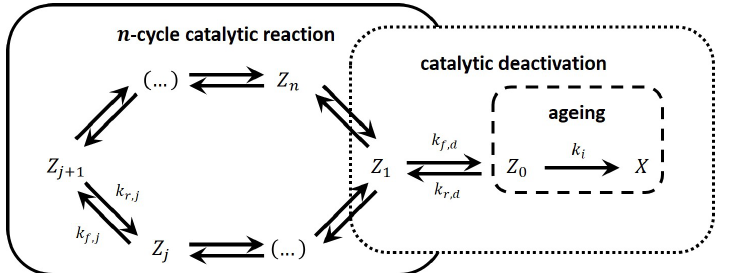
Figure 1. The three-building-block scheme approach to phenomenological modeling for a linear catalytic reaction accompanied by linear catalyst deactivation. Block one is a n -step linear catalytic reaction. Block two is a linear reversible catalyst deactivation. Block three is aging, i.e., linear irreversible catalyst